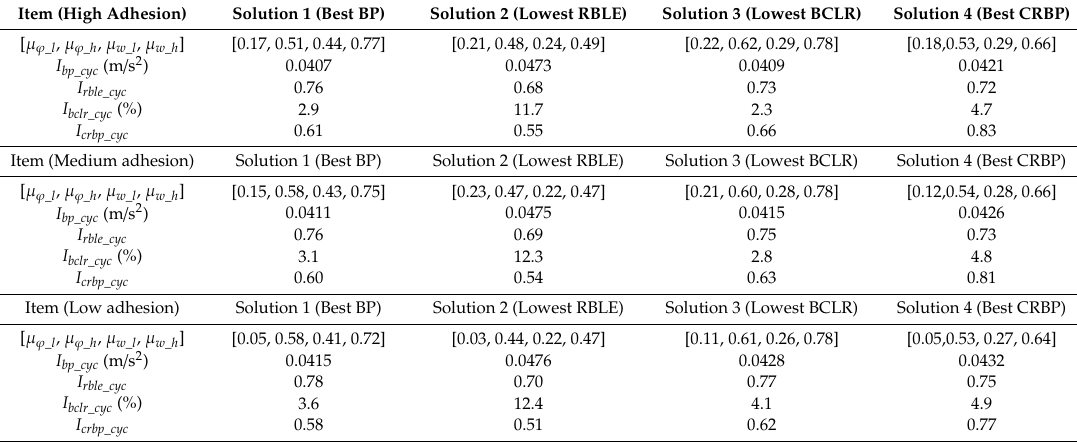
Table 2. Optimization